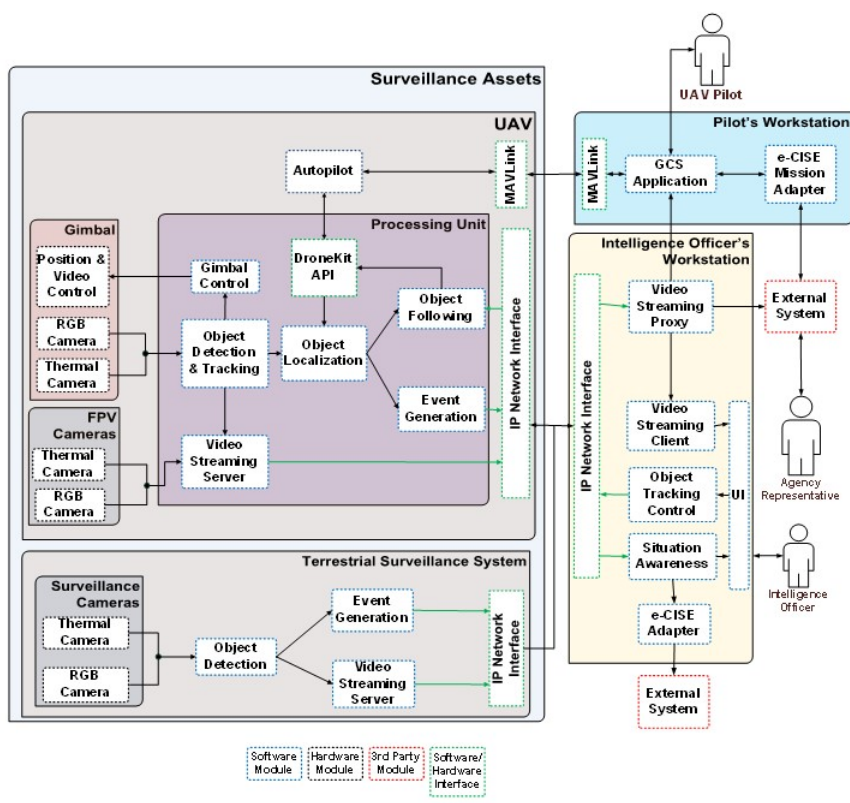
Figure 1. The proposed situational awareness system, namely the INUS